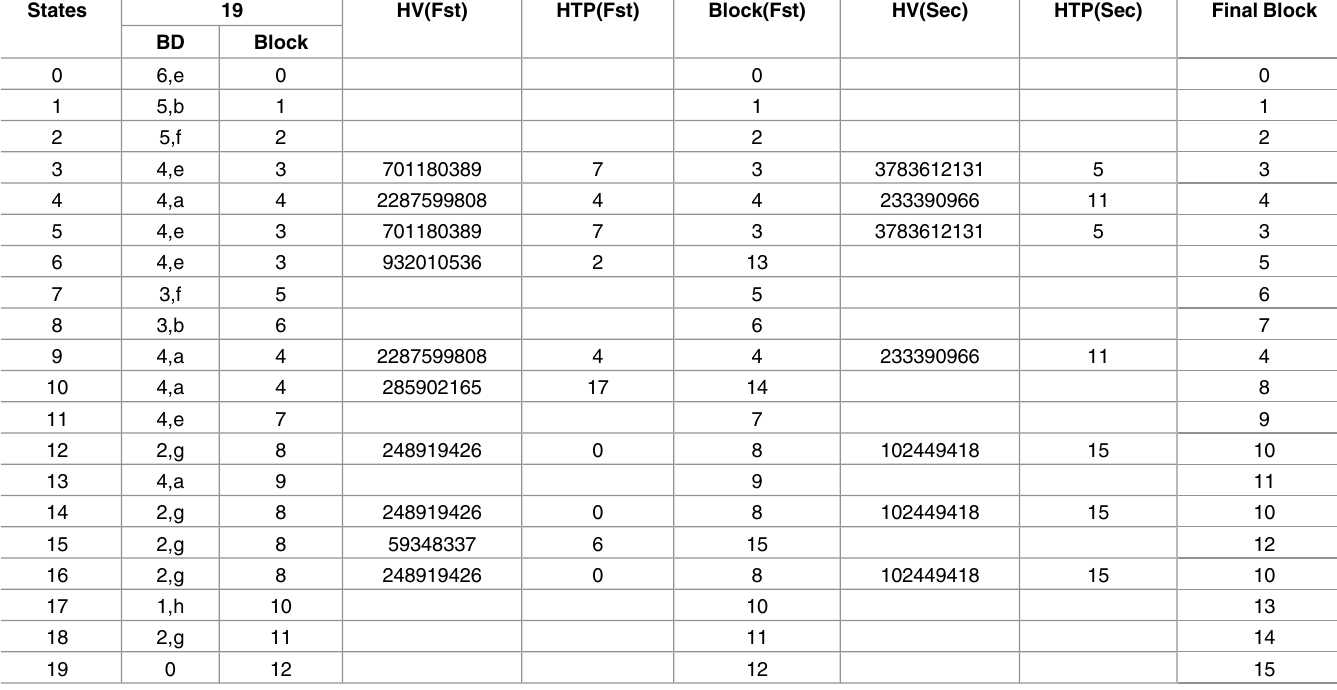
Table 3. Hash table refinement based on the coarse partition of accepted state